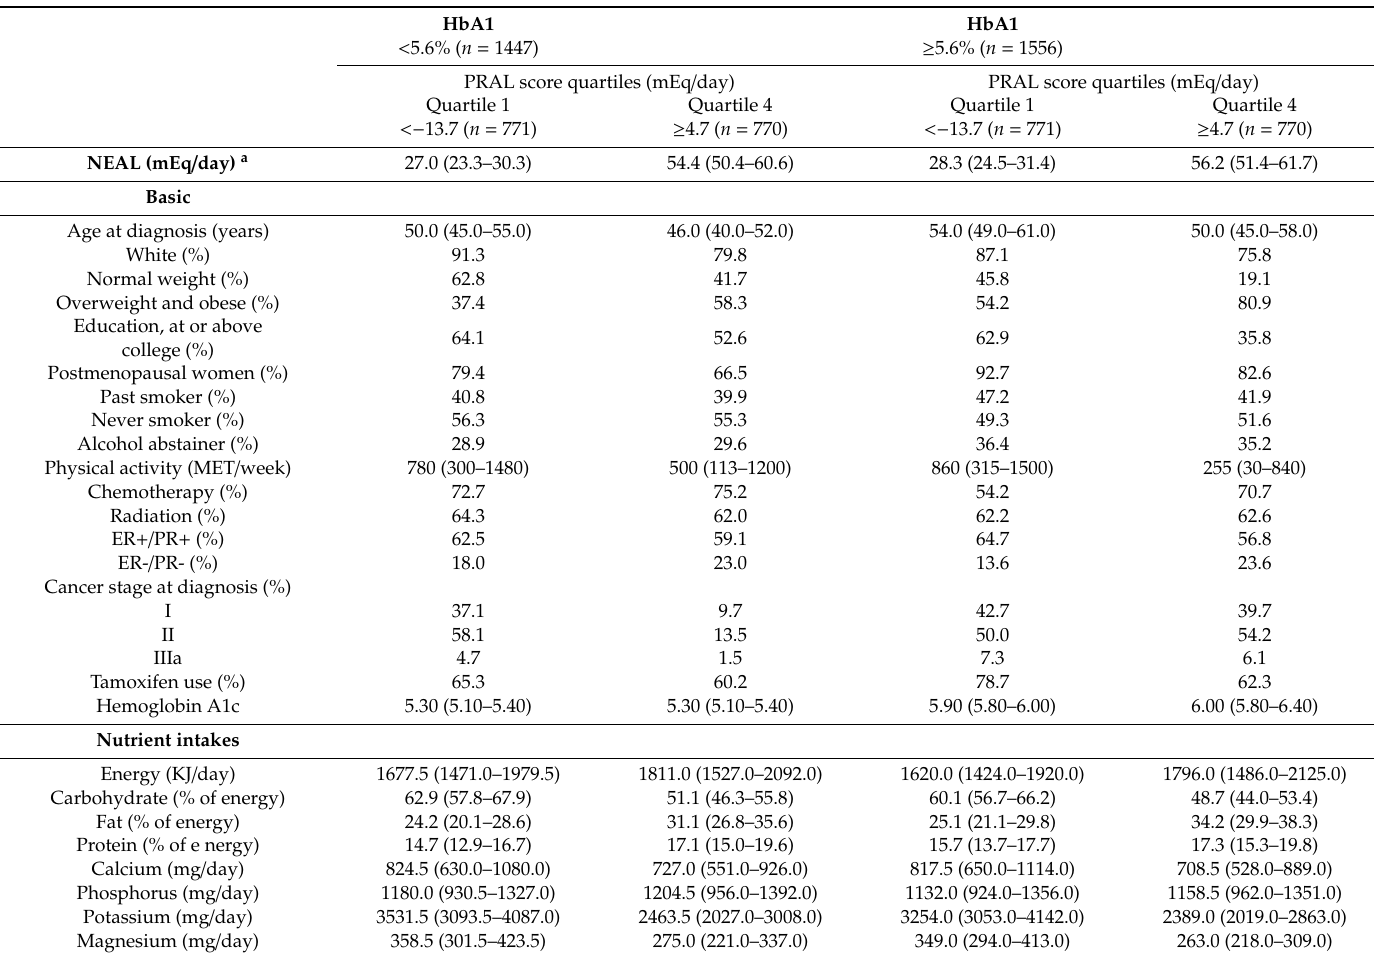
Table 3. Characteristics of breast cancer survivors at baseline by hemoglobin A1c (HbA1c) levels and the PRAL